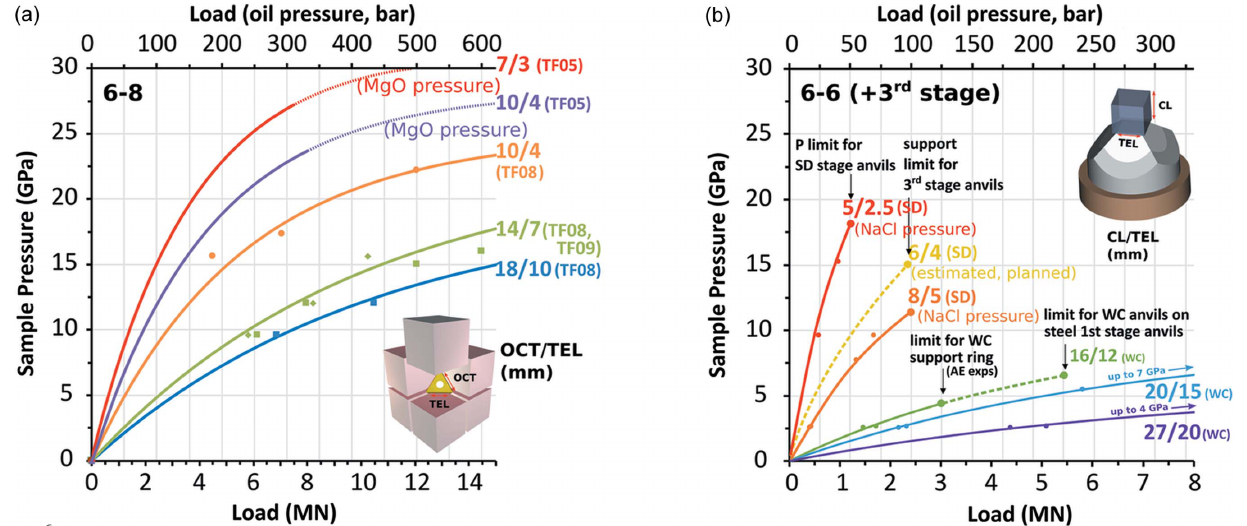
Figure 6 Pressure calibration curves obtained for the various assemblies used in the LVP for ( a ) the ‘Kawai’ 6–8 compression geometry and for ( b ) the cubic 6–6 (+third stage) compression geometry. Note, most pressure curves are only valid at room temperature and do not account for the thermal expansion and stress release and flow of the pressure medium at high temperatures. Typically the entire press load range can be used for 6–8, though this is not the case for 6–6 compression due to the reduced anvil support in the cubic geometry. Some of these limits are indicated in ( b